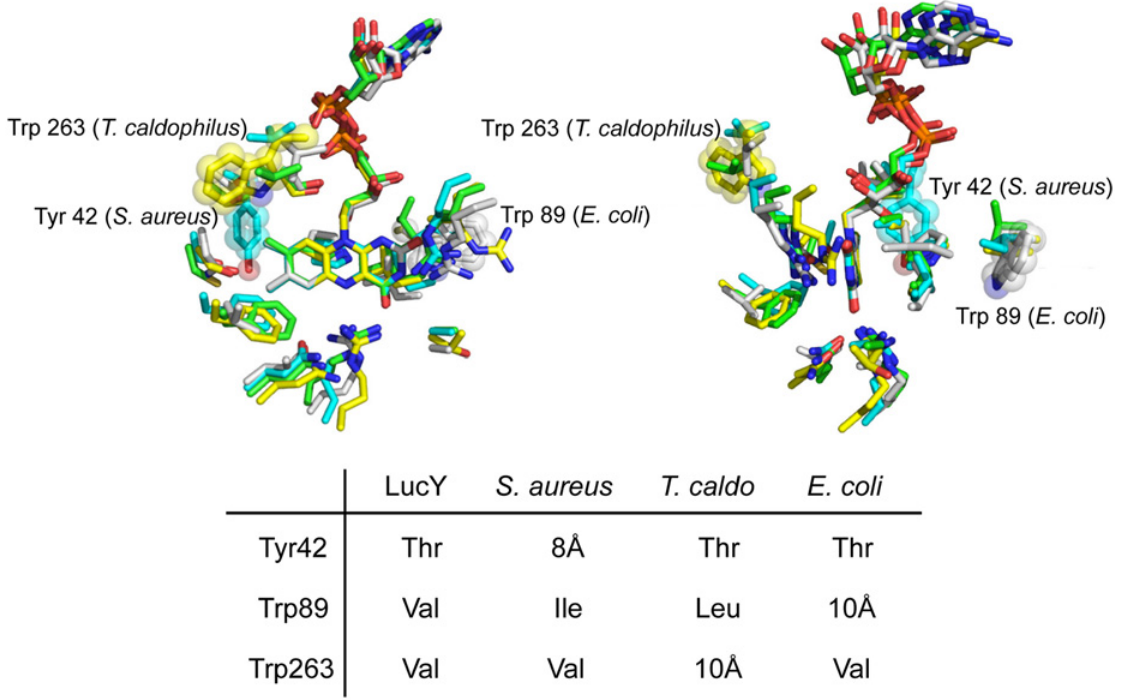
Fig 7. Alignment of active site structure of MurB enzymes. Amino acid residues are aligned within 5 Å of the isoalloxazine moiety of FAD as well as at the positions of the proposed quenching residues Trp 263 (T. caldophilus), Trp 89 (E. coli), and Tyr 42 (S. aureus) shown as spheres and sticks. All other residues and FAD are shown as sticks. Carbon is color coded as follows: LucY (green), E. coli (white), S. aureus (cyan), and T. caldophilus (yellow). Nitrogen is in blue, oxygen red, and phosphorus orange. The right figure is a 90o rotation view of the left figure around the vertical axis. Structure alignment by PyMOL [62] is based on the isoalloxazine moiety of FAD. Inset tabulates the presence of Trp or Tyr in MurBs, with the exception of LucY. Residue numbering corresponds to species with Tyr/Trp. T. caldo for T. caldophilus.